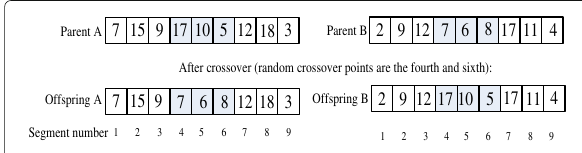
Fig. 8 Partial matching crossover operator used in the node gene